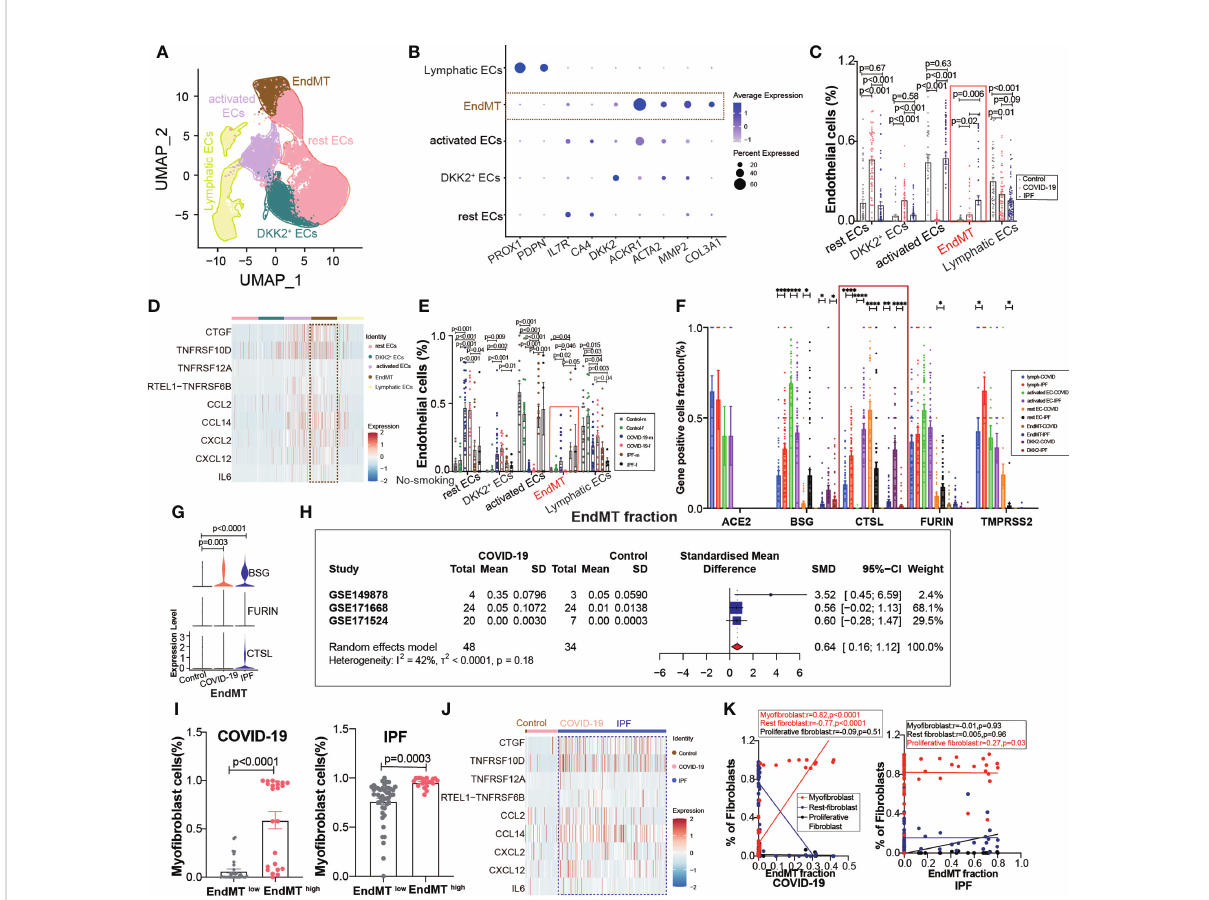
FIGURE 4 EndMT proportion is upregulated in COVID-19. (A) The expression of pulmonary ECs in patients with health control, COVID-19, IPF was demonstrated using UMAP plots with subpopulations marked by a color code. ECs subpopulations including rest ECs, EndMT, DKK2 + ECs, activated ECs; Lymphatic ECs. (B) Dot chart shows the marker of EndMT, mainly focusing on ACTA2, MMP2, COL3A1; rest ECs (IL7R, CA4), DKK2 + ECs (DKK2), activated ECs (ACKR1); Lymphatic ECs(PROX1,PDPN). (C) Proportion of ECs among normal control group, COVID-19 group and IPF group, the ratio of EndMT was increased in COVID-19 and IPF than controls. One-way ANOVA was used to compare multiple groups (p<0.05). (D) Heatmap shows a comparison of the expression of major cytokines in the cell subpopulations of ECs shows that EndMT is enriched in more cytokines compared to the other groups. (E) Comparison of the ratios of HC, COVID-19, IPF subpopulations of ECs by gender in nonsmokers. EndMT ratio in females is lower than that in males with COVID-19. (F) Comparison of entry factors (ACE2, BSG, FURIN, CTSL, TMPRSS2) positive cell fraction in ECs subtype of COVID-19 and IPF. (G) Comparison of EndMT proportion of entry factors (BSG, FURIN, CTSL) in HC, COVID-19, IPF. (H) Forest plot of studies with lung scRNA data on the COVID-19, after excluding a study with only one case and a high heterogeneity study. The analysis included data from 3 studies with a total of 48 COVID-19 and 34 controls. p value for heterogeneity was 0.18, I 2 was 42%. (SD: Standard deviation). (I) Ratio of myo fi broblasts in COVID-19 and IPF for EndMT low versus EndMT high , showing myo fi broblast ratio in EndMT high is higher than that in EndMT low . (J) A comparison of the expression of major cytokines in the EndMT shows that COVID-19 and IPF are enriched in more pro fi brotic cytokines compared to HC group. (K) Correlation analysis of EndMT with myo fi broblast, rest fi broblast and pro fi lerative fi broblast in COVID-19 and IPF patients (Pearson test), showing EndMT is positively correlated with myo fi broblasts in COVID-19 patients. * P < 0.05, ** P < 0.01, *** P < 0.001,**** P <